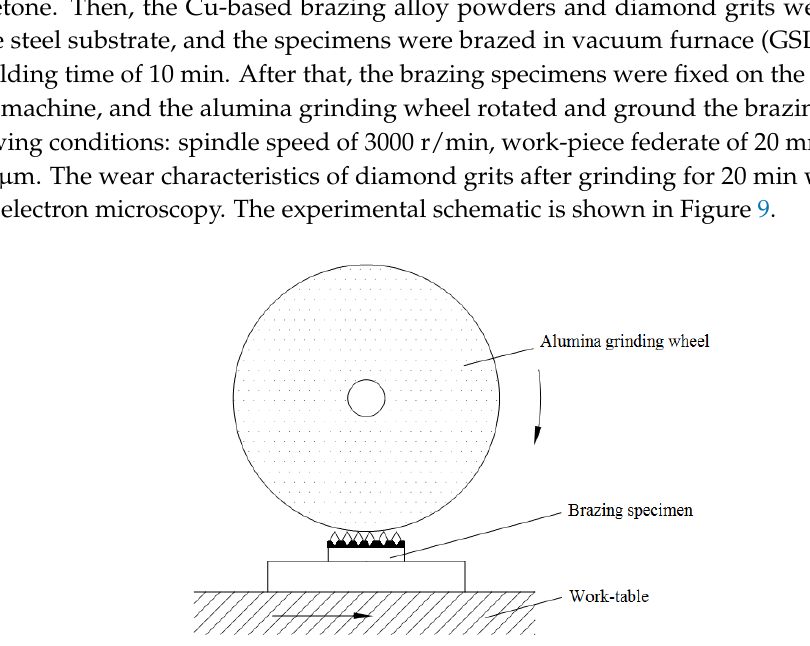
Figure 9. The experimental schematic for investigating wear characteristics of diamonds.